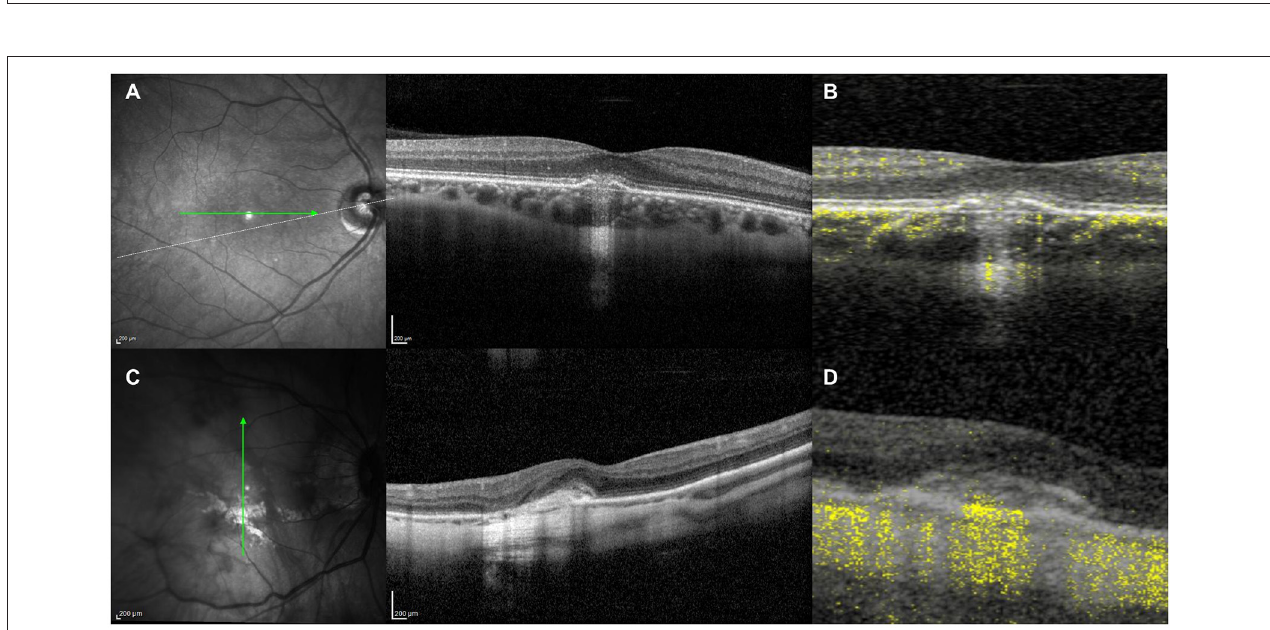
FIGURE 8 | (A) Structural optical coherence tomography (OCT) scan showing typical signs of an acute inflammatory lesion in a 41-year-old myopic female with central vision loss including focal retinal pigment epithelium (RPE) disruption with elevation of the borders leading to underlying choroidal hypertransmission, associated with subretinal hyperreflective material and disruption of the overlying external limiting membrane (ELM) and photoreceptors ellipsoid zone. (B) Structural OCT scan with flow signal overlay as analyzed by OCT-Angiography (OCT-A) ruling out the presence of flow signal within the inflammatory lesion, which allows to discard the presence of choroidal neovascularization. (C) Structural OCT scan showing signs of exudation with high-density subretinal material in a 52-year-old myopic female with previous history of multifocal choroditis. (D) Structural OCT scan with flow signal overlay as analyzed by OCT-A confirming the presence of flow signal within the subretinal hyperreflective tissue, suggestive of choroidal neovascularization.